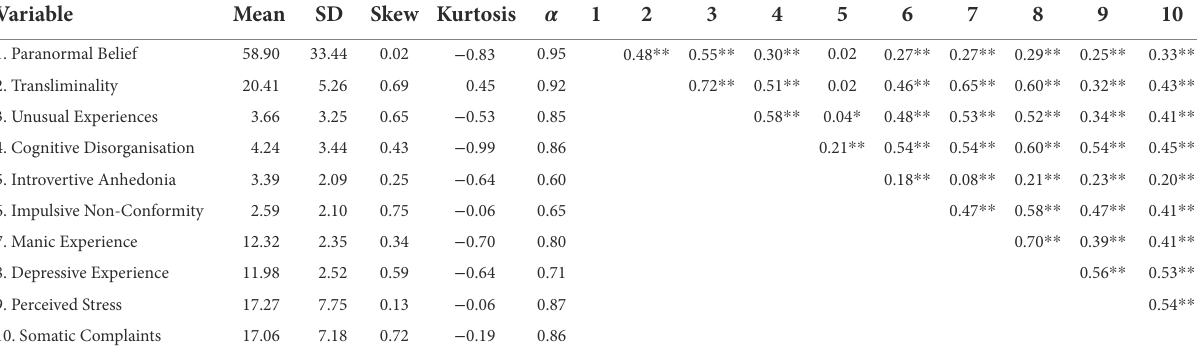
TABLE 1 Descriptive statistics and